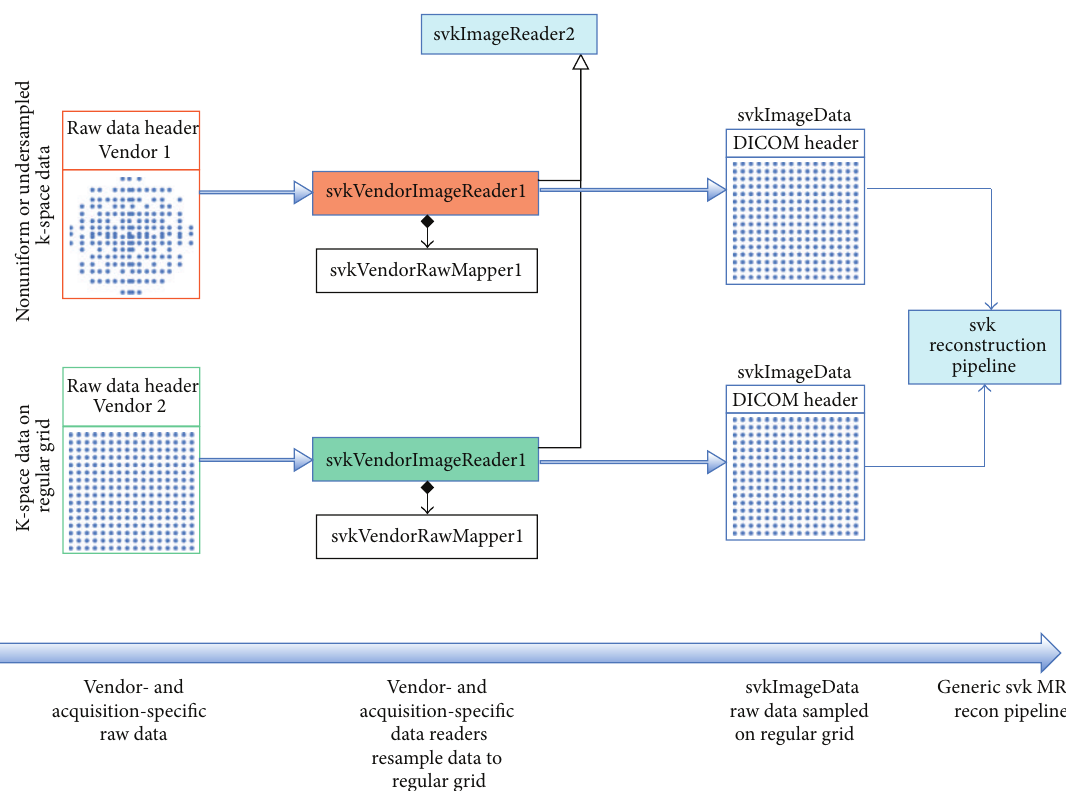
Figure 12: svk raw data readers handle acquisition-specific data reorganization. This includes vendor-specific header parsing and acquisition- specific data reordering and resampling. The output of an svkImageReader is always an svkImageData object, represented by a DICOM header and data sampled on a regular grid that is suitable for FFT-based reconstruction. This permits the use of a common set of independent downstream reconstruction and processing algorithms, independent of the acquisition sequence or vendor data format. An svkImageReaderFactory reads the raw data files to create the appropriate type of svkImageReader for the specific input format and acquisition type. Vendor- and acquisition-specific readers load data and associated mappers resample data to a regular